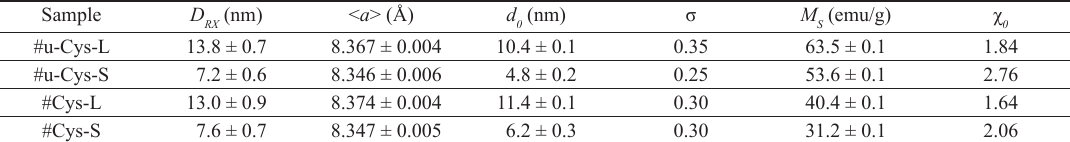
is the saturation magnetization and χ S